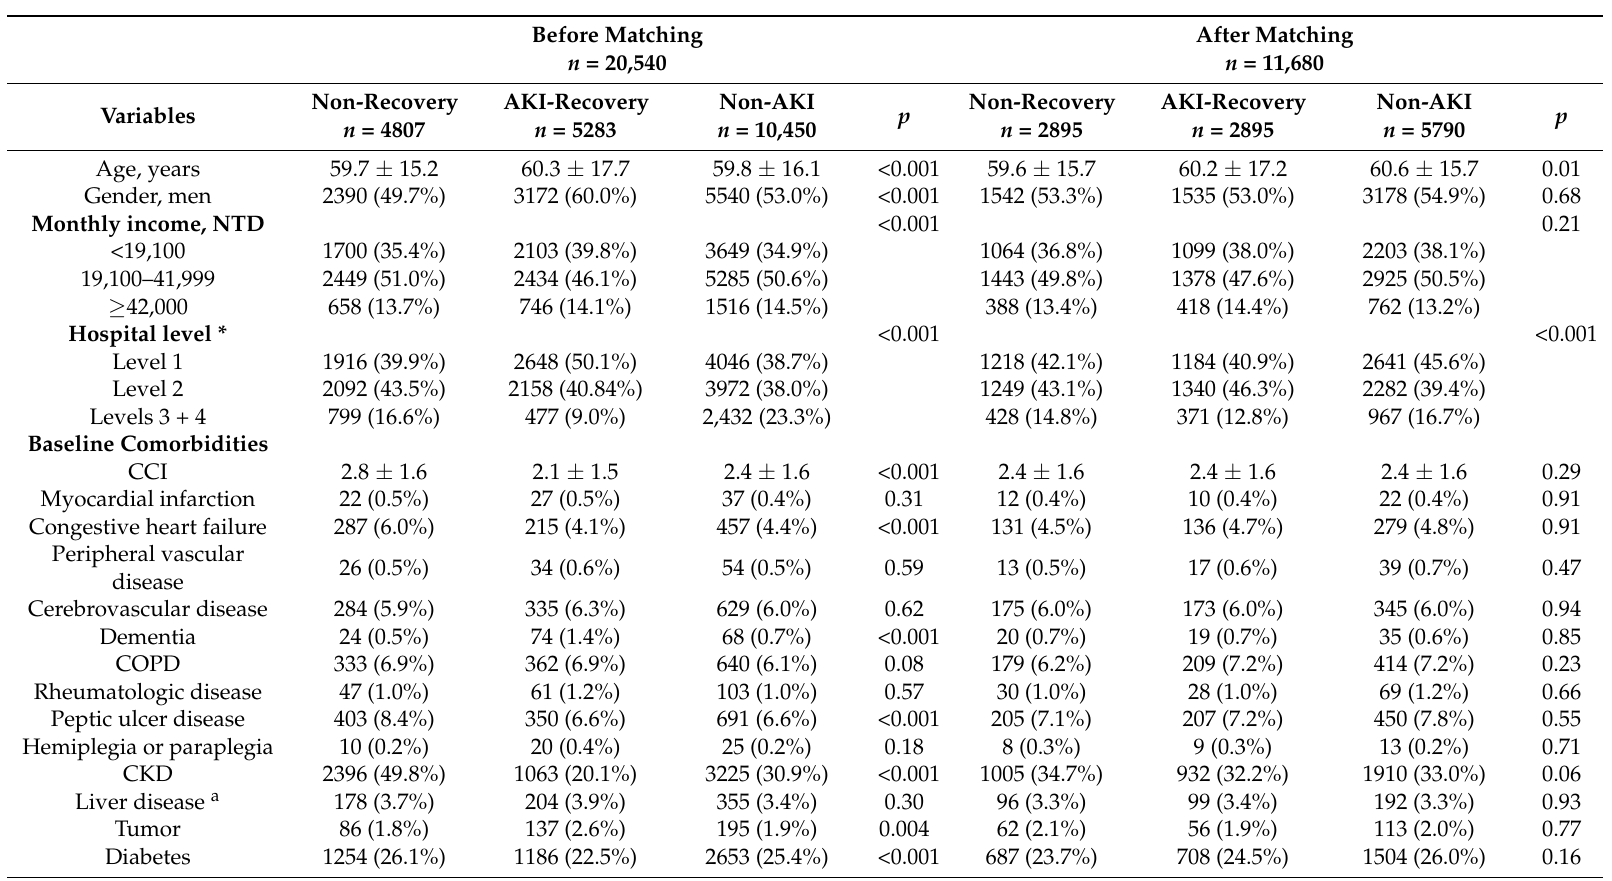
Table 1. Comparisons of the baseline characteristics among the three